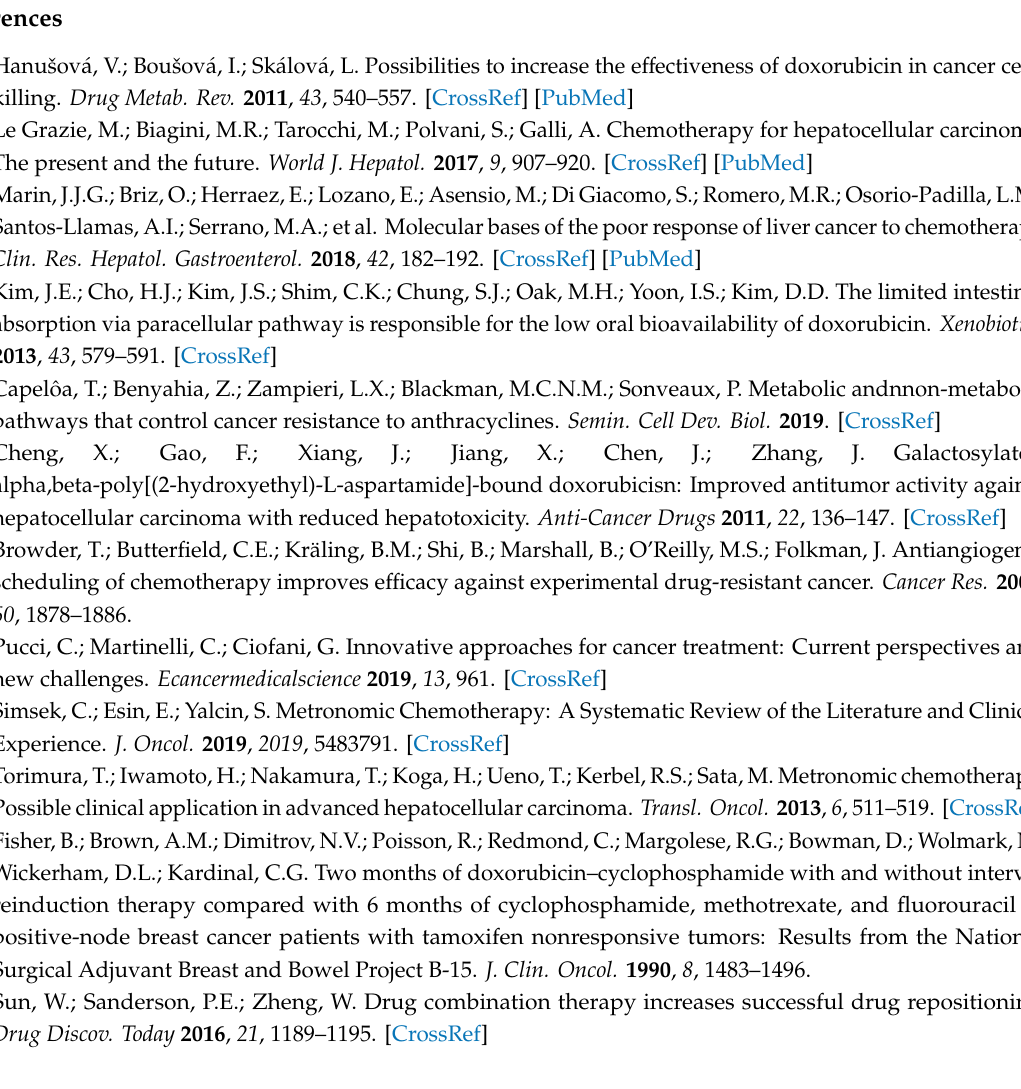
Figure S3: E ff ect of the natural sesquiterpenes β -caryophyllene and β -caryophyllene oxide in combination with the anticancer drug cisplatin in HepG2 cells after 24 and 72 h exposure. Figure S4: Contribution energy of each amino acid to the binding energy of verapamil in kJ / mol. Figure S5: 2D-map of verapamil in the binding site of P-gp representing interactive amino acids and types of interactions. Figure S6: RMSD (Root-mean-square deviation) curve of the protein during 1 ns dynamic simulation. Table S1: Contribution energy values per the most important residues in kJ / mol for the sesquiterpenes β -caryophyllene and β -caryophyllene oxide and for the standard control